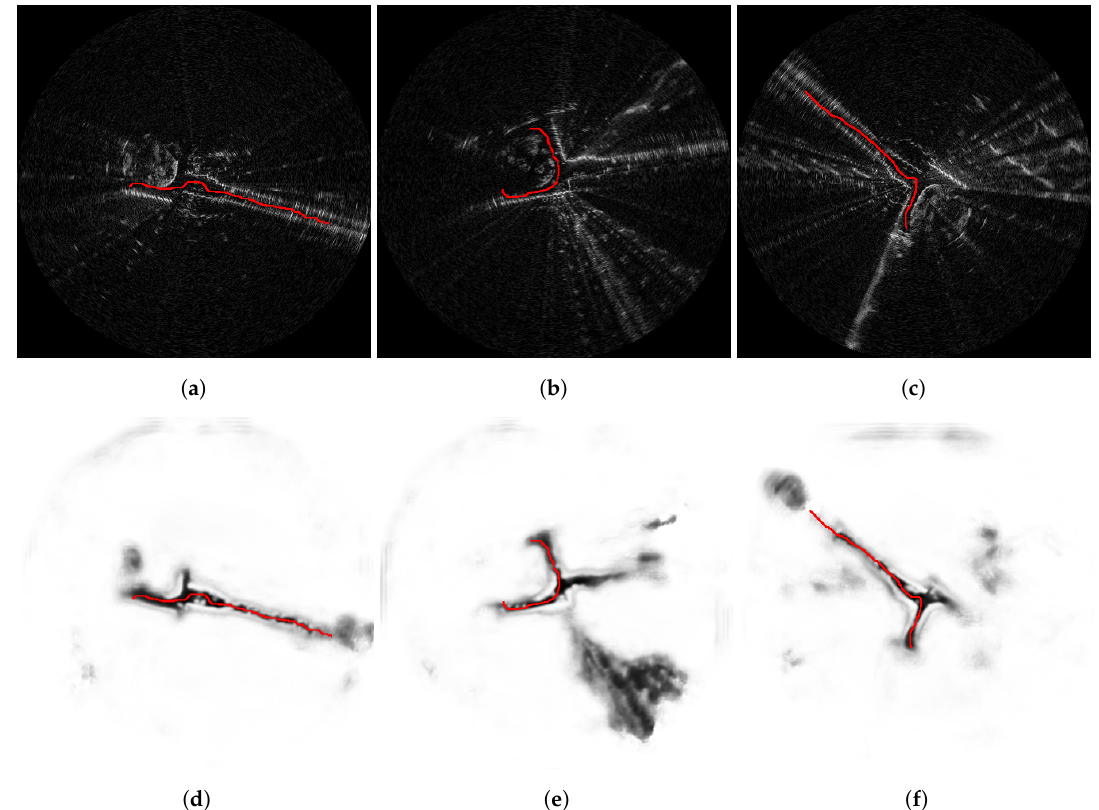
Figure 16. A sample of maximally traversable routes evaluated using the A* graph search algorithm. ( a – c ) show the optimally traversable routes (red) projected onto the corresponding FMCW radar scans. ( d – f ) represent the vertex weighted graphs which are computed from the inferred traversability maps and on which the minimum cost routes between the start and destination points are projected. The routes evaluated using the A* algorithm are found to be robust for a wide range of radar scans in the test data, including those with significant artefacts present. They reliably navigate around obstacles while exhibiting paths that are direct, implying good performance from the traversability prediction network. The smoothness of the inferred paths leaves something to be desired; however, an issue which is resolved by the multi-task learned model in Section